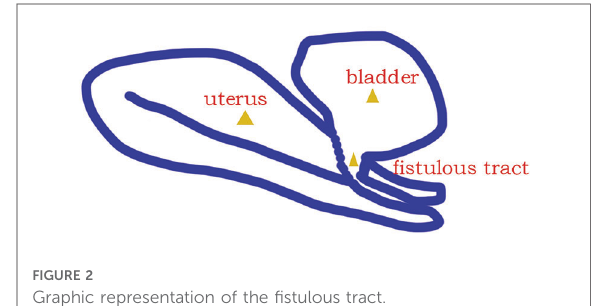
FIGURE 2 Graphic representation of the fi stulous tract.